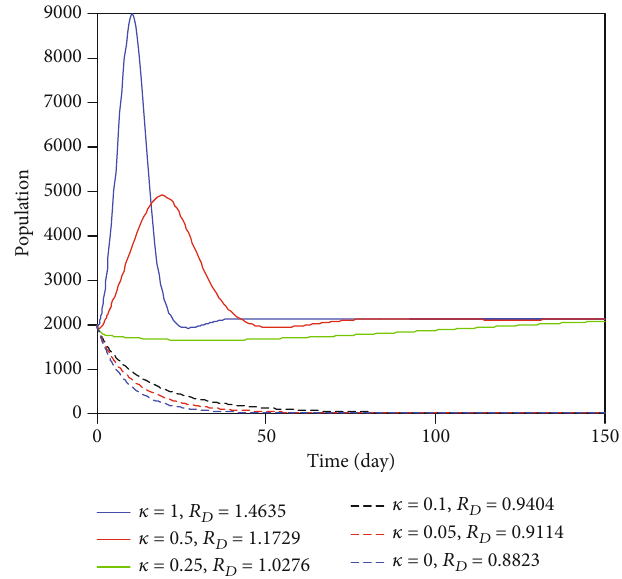
Figure 4: The dynamics of infectious population for α = 1 with di ff erent values of κ and other parameter values are given in Table 1.